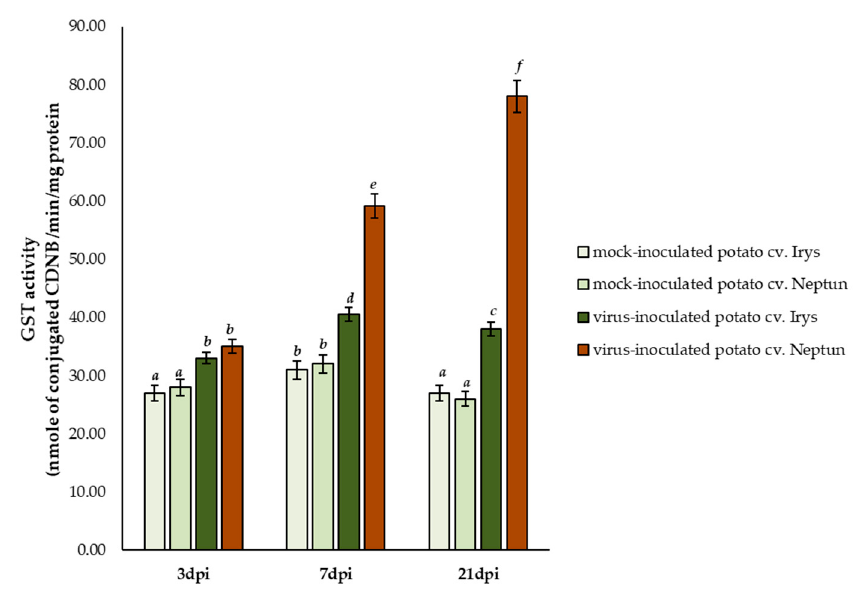
Figure 5. GST activity in nanomoles of conjugated CDNB in the leaves of PVY NTN and mock inoculated Irys and Neptun potato plants between 3 and 21 dpi. Using ANOVA and Tukey’s HSD test, the mean concentrations of GSH and GSSG were calculated at p < 0.05. The statistically significant values are marked by letters above the bars.